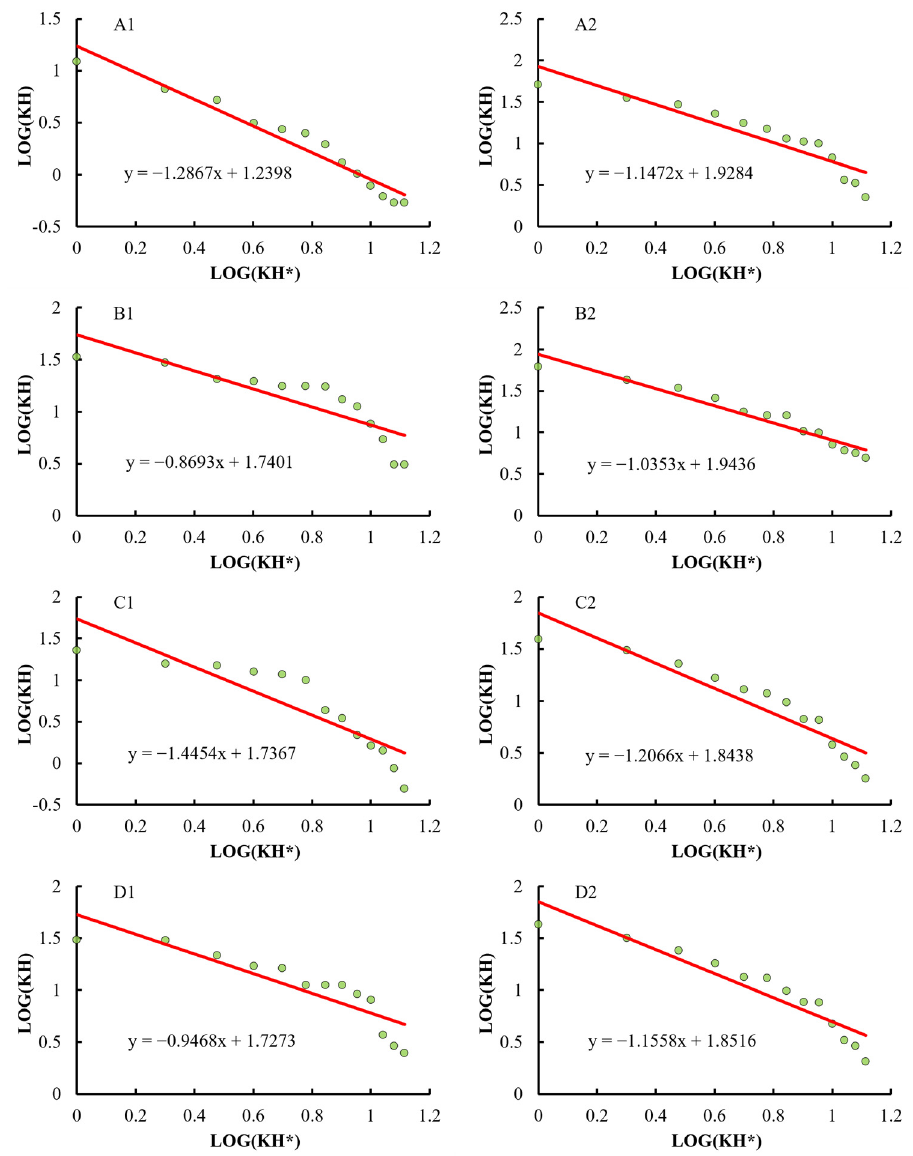
Figure 9. Changes in the weighted degree distribution of population mobility networks in different periods.